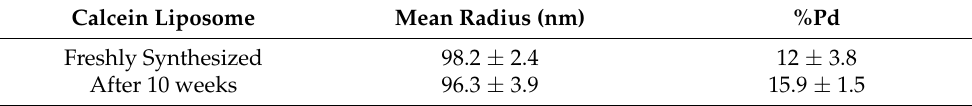
Figure 1. Light-scattering measurements on calcein-loaded liposome. DLS of newly synthesized calcein liposomes and after 10 weeks of storage at 4 °C of the same batch. Table 1. Dynamic light scattering measurements of calcein liposomes.